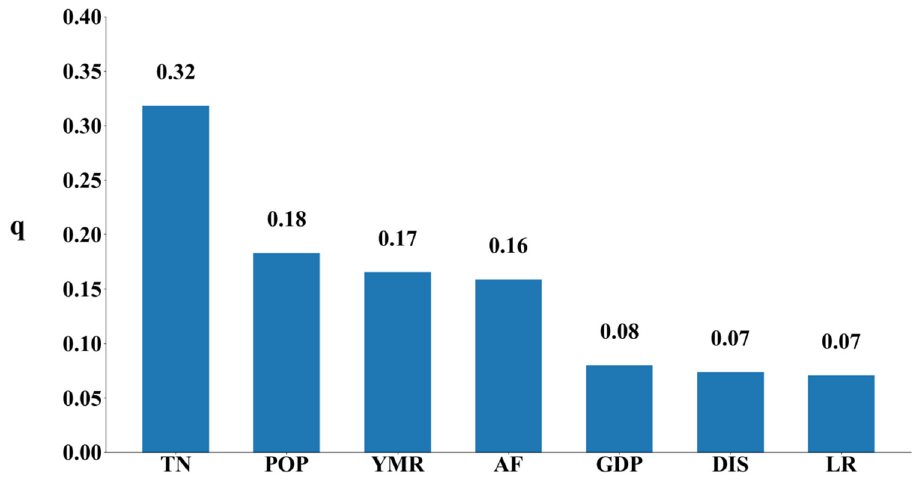
Figure 8. Results of factor detection.